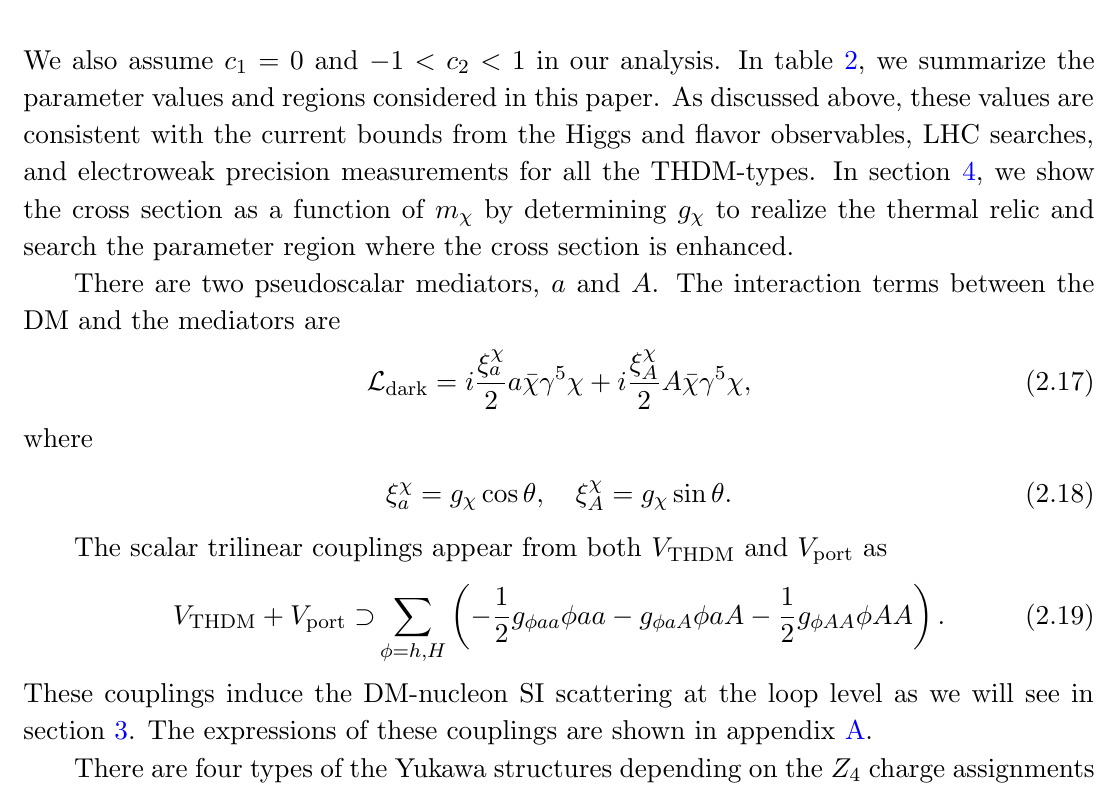
Table 2 . The parameter values and regions discussed in this paper. These values are allowed from the bounds of the Higgs and (cid:13)avor observables, LHC searches, and electroweak precision measurements for all the